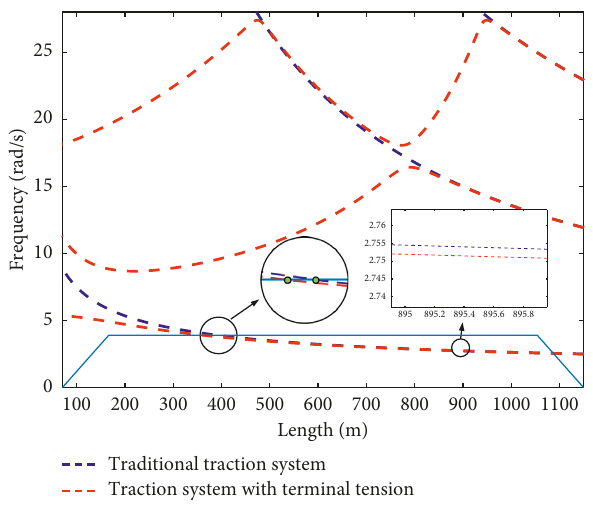
Figure 15: Comparison of the natural frequencies of the two- traction